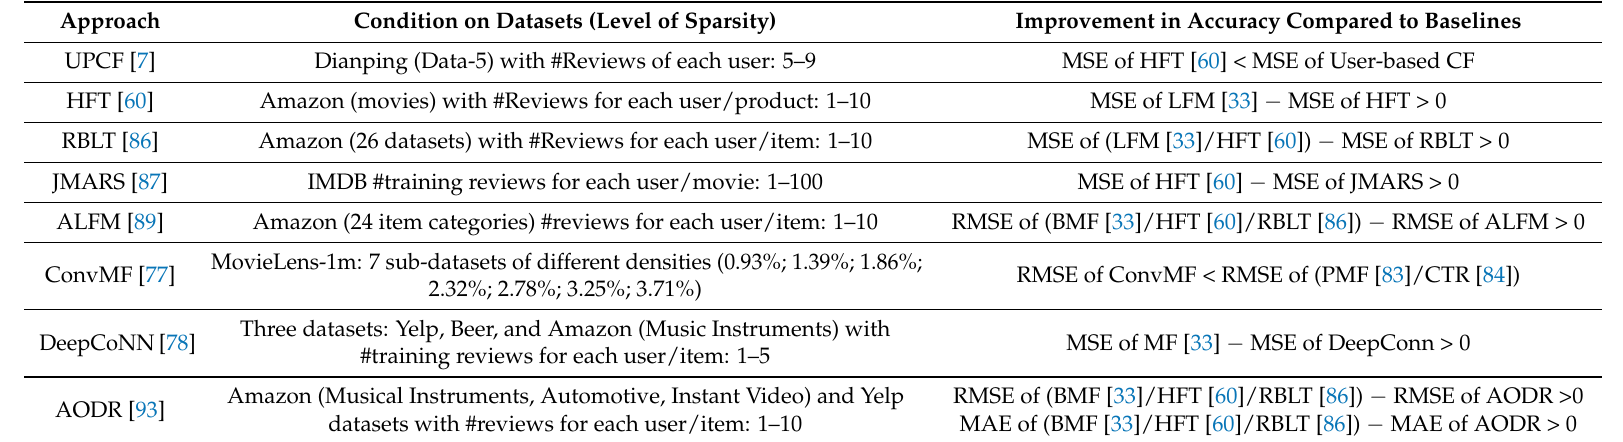
Table 7. Comparisons based on Sparsity